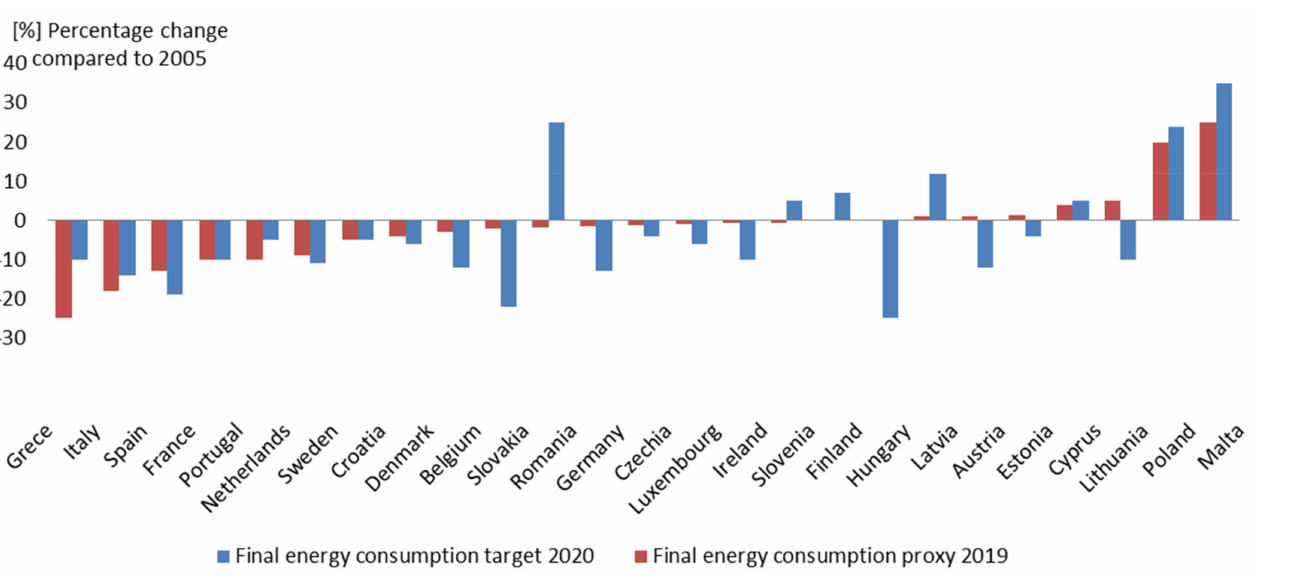
Figure 6. The changes in energy consumption of EU member states